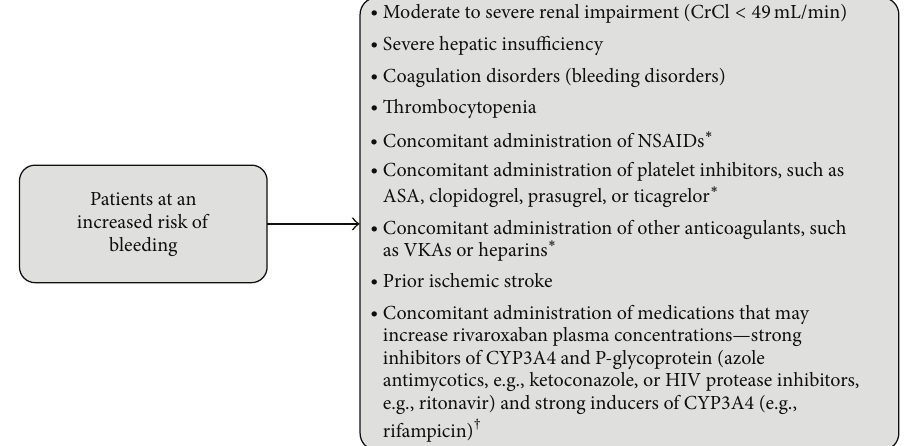
Figure 1: Factors associated with increased risk of bleeding with rivaroxaban [2]. ∗ Care is to be taken in patients receiving concomitant systemic treatment with these agents and rivaroxaban. † Rivaroxaban is not recommended in patients receiving concomitant systemic treatment with these agents. ASA = acetylsalicylic acid; CrCl = creatinine clearance; CYP3A4 = cytochrome P450. 3A4; HIV = human immunodeficiency virus; NSAID = nonsteroidal anti-inflammatory drug; VKA = vitamin K antagonist.